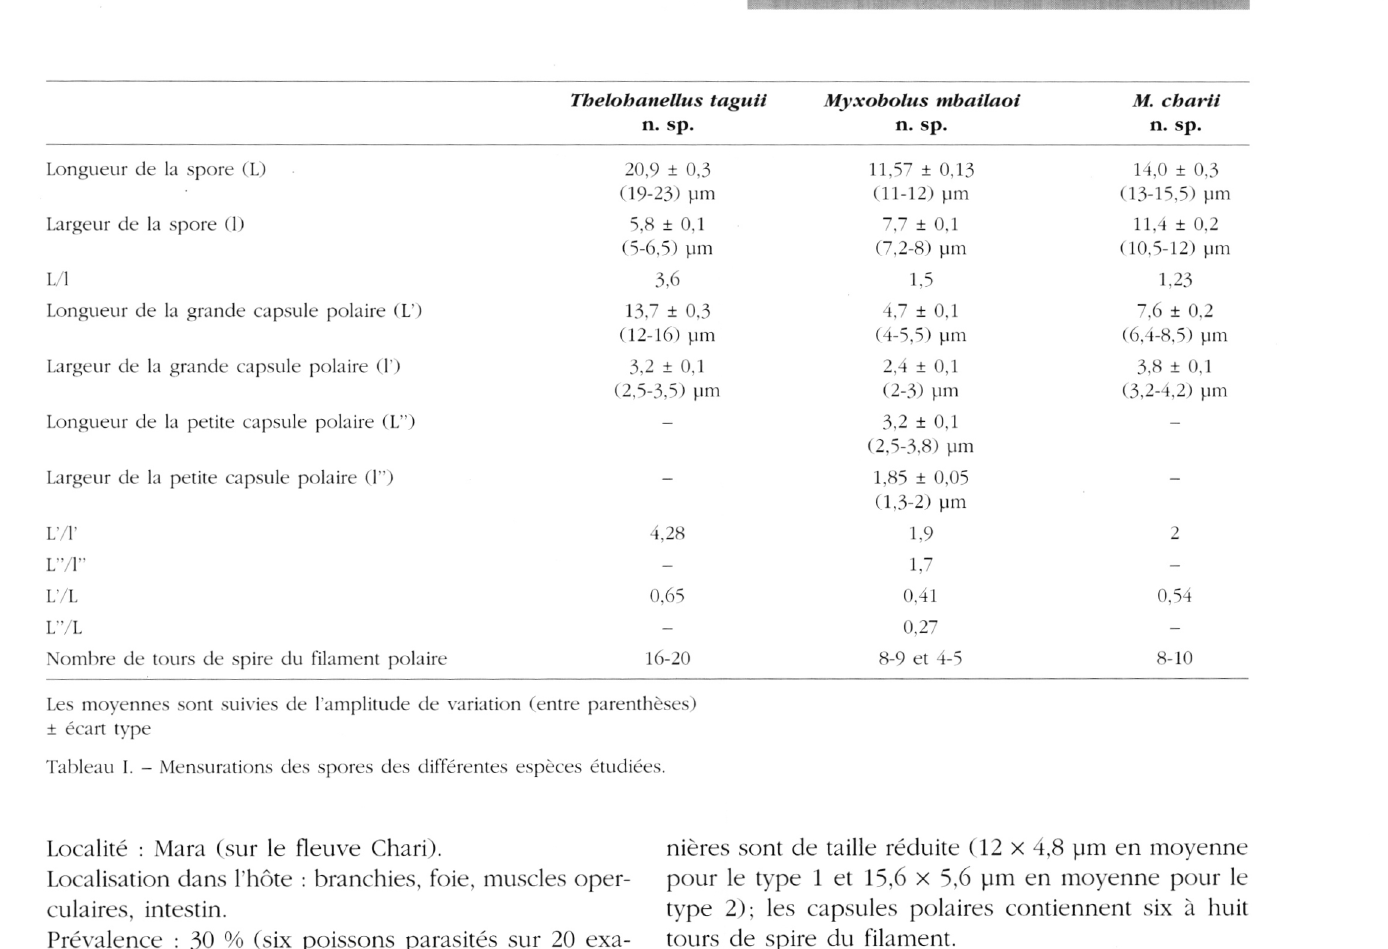
Localité : Mara (sur le fleuve